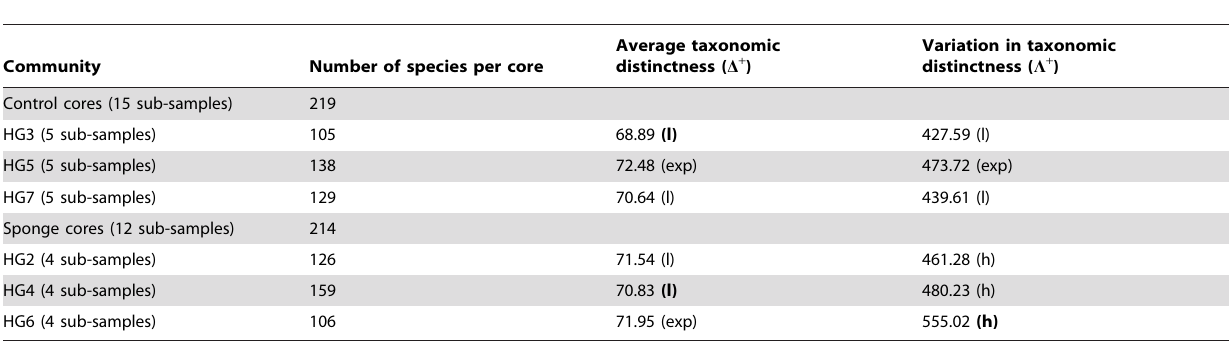
Table 4. Taxonomic diversity indices and species number of the nematode communities from control and sponge cores (0–1 cm sediment depth).